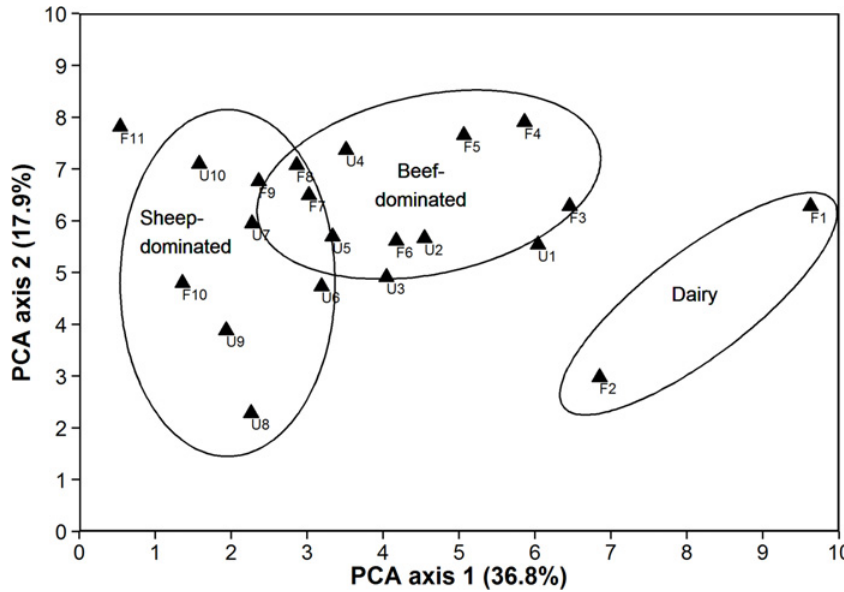
Figure 2. Biplot of PCA axes 1 and 2 showing the dominant gradients of variation in land-use intensity across farms, based on four short-term farmer input measures and nine longer-term soil biogeochemistry measures (see S2 Fig. for factor loadings). Land-use intensity increased (left to right) with the change in type of farming from sheep-dominated to beef-dominated to dairy-dominated. Note that all sheep-dominated farms had a mix of livestock types, including sheep, beef and dairy grazing, whereas most beef-dominated farms did not have sheep (see S2 Table for a breakdown of stocking rates per livestock class). Ellipses are for illustrative purposes